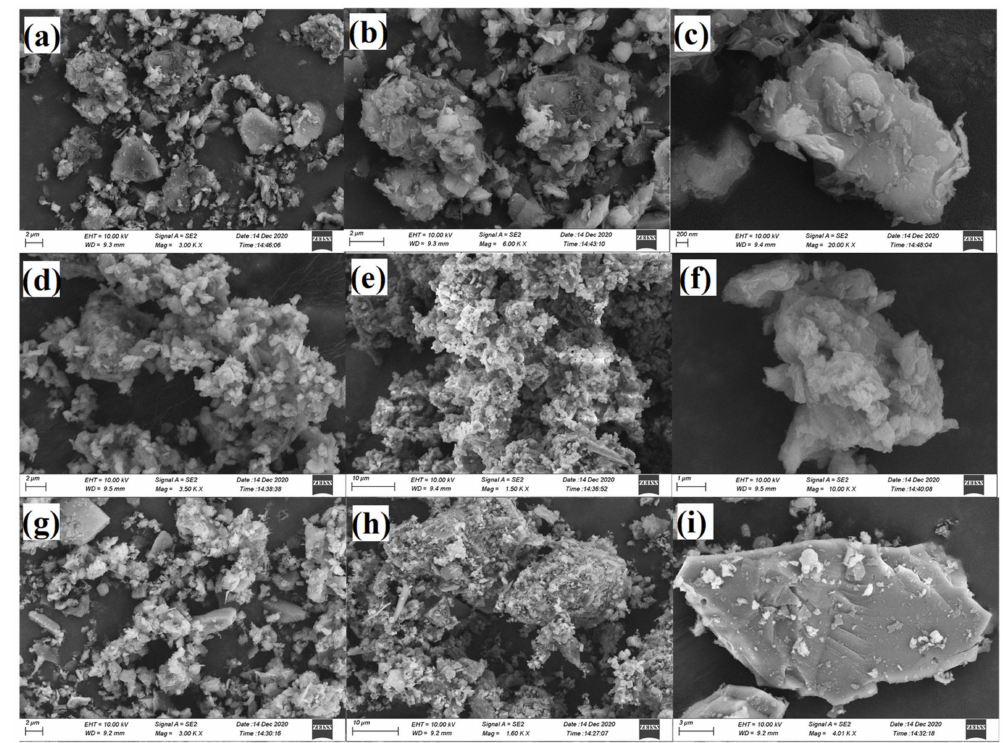
Figure 6. SEM morphology analysis diagram of raw ore ( a – c ), roasted ore ( d – f ), and leaching residue ( g – i